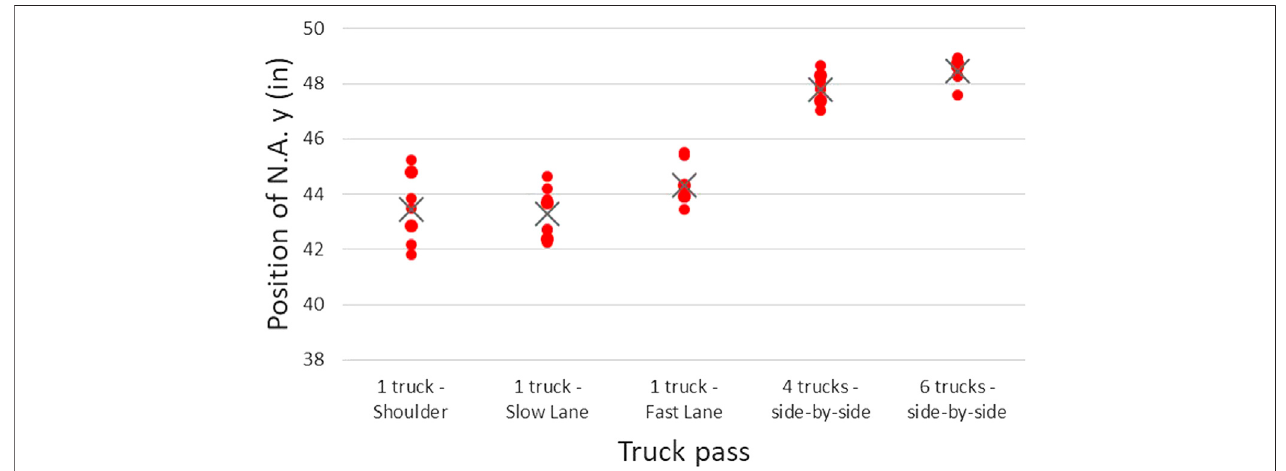
FIGURE 5 | N.A. minimum values in the west edge girder at controlling location (CL) over the different passes of the load tests (single truck passes in the southbound lanes). X sign represents the average position of N.A. y for each different pass.